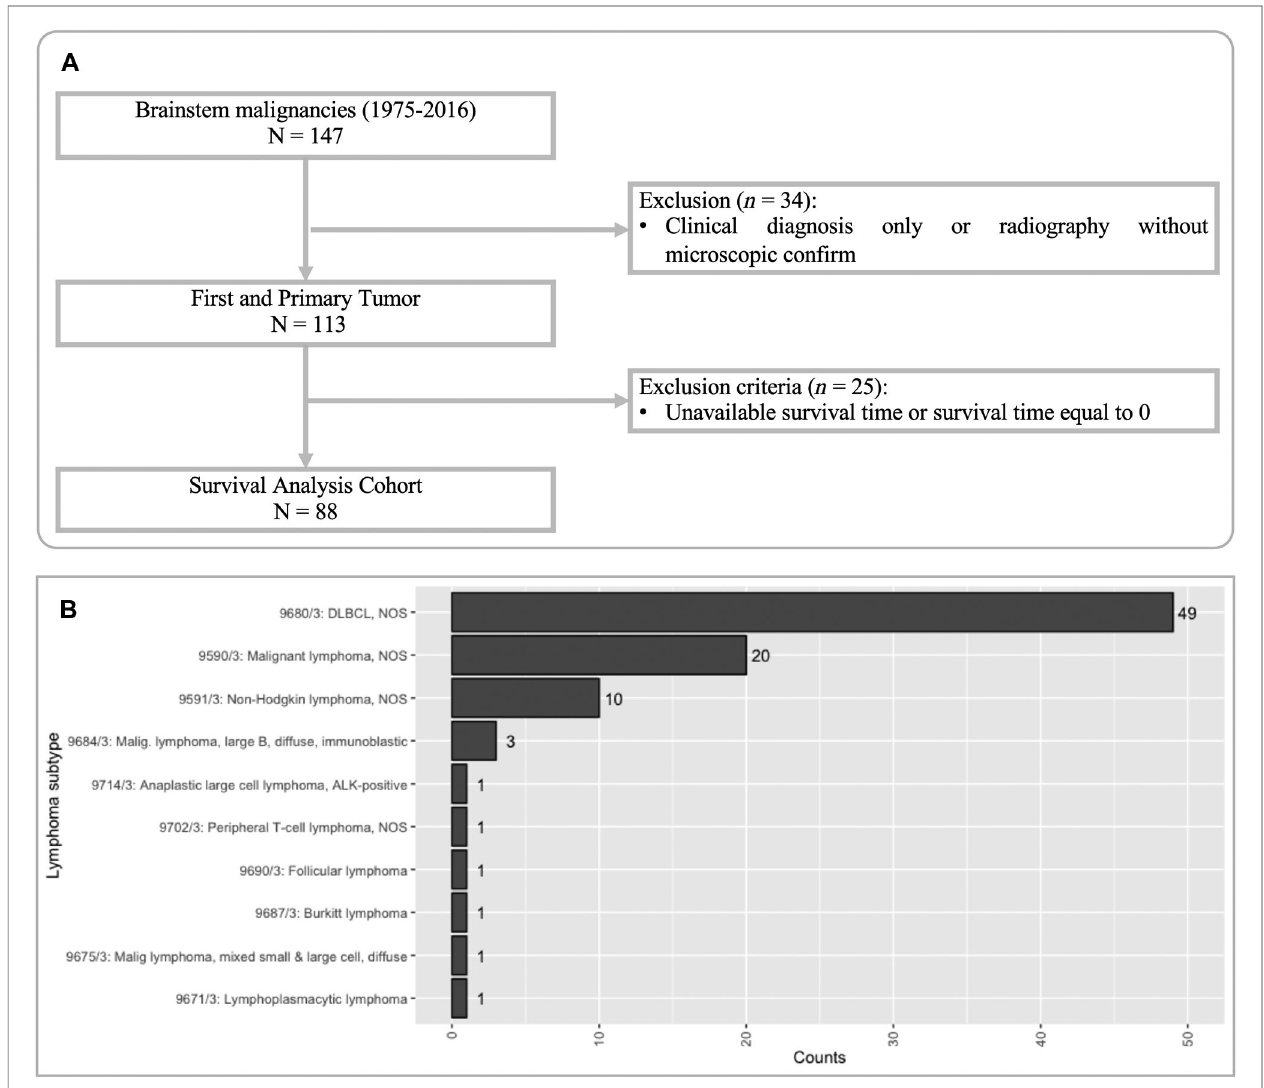
FIGURE 1 | ( A ) Flow diagram of study cohort selection. ( B ) Histological variants of primary brainstem lymphoma (PBSL). ALK, anaplastic lymphoma kinase; DLBCL, diffuse large B cell lymphoma; NOS, not otherwise speci fi